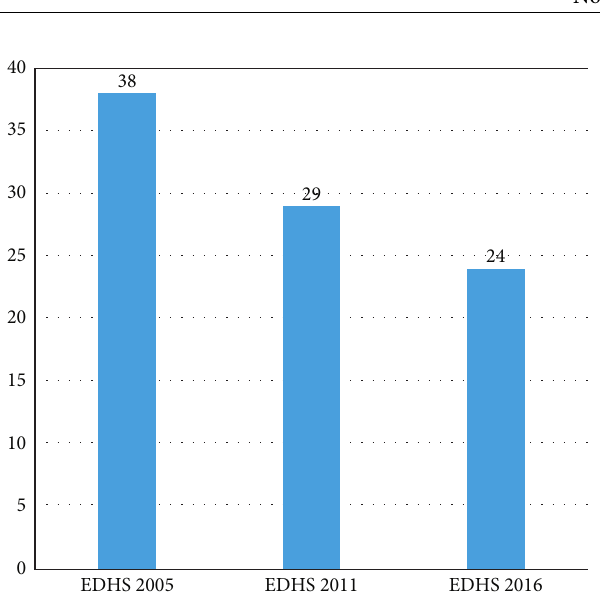
Figure 1: Trends of underweight among children under five years in Ethiopia, evidence from EDHS